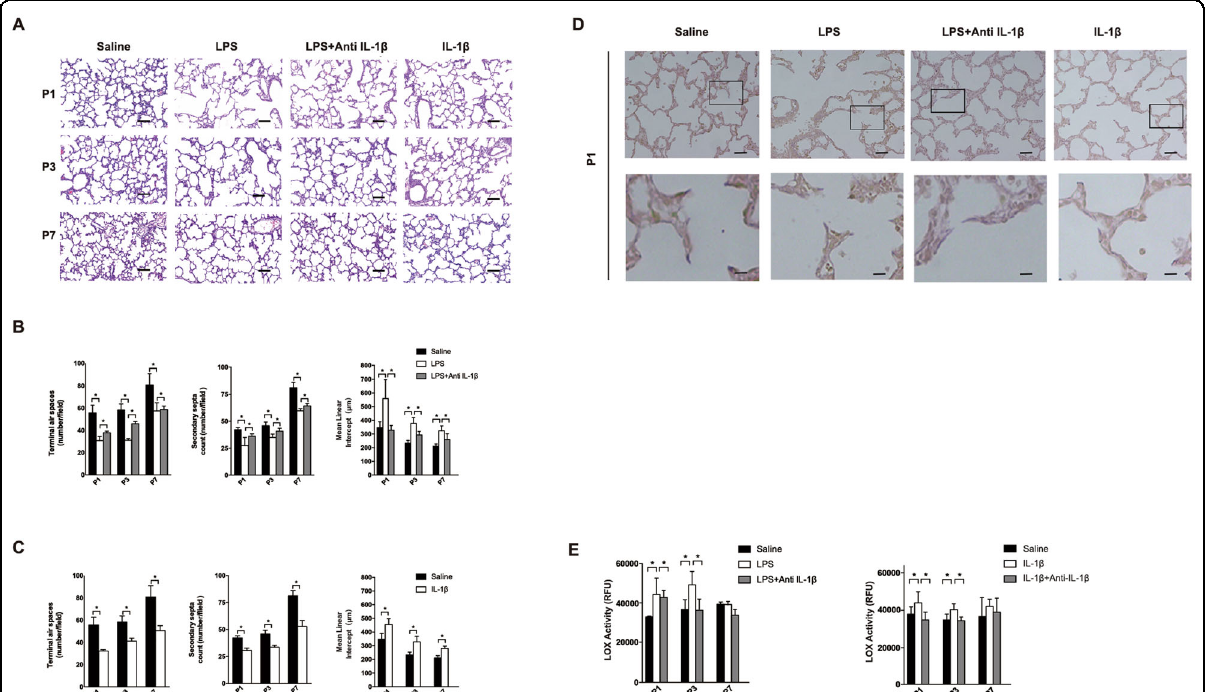
Fig. 1 IL-1 β mediated arrested effects on alveolarization in the alveolar development phase. A Representative lung sections stained with H&E. Scale bar: 50 μ m. B Quanti fi cation of the terminal airspace, secondary septa, and MLI of lung tissues from P1, P3, and P7 rats treated with LPS and anti- IL-1 β antibody. Data are expressed as mean ± SD ( n = 6), * p < 0.05. C Quanti fi cation of the terminal airspace, secondary septa, and mean linear intercept of lung tissues from P1, P3, and P7 rats treated with IL-1 β . Data are expressed as mean ± SD ( n = 6), * p < 0.05. D Representative lung sections stained with gomori (Ampli fi ed). Top: Scale bar: 50 μ m. Bottom: Scale bar: 25 μ m. Treatment with either LPS or IL-1 β resulted in abnormal elastin deposition in the lung septal, whereas adding anti-IL-1 β antibody normalized elastin. E Quanti fi cation of LOX enzymatic activity in whole lung lysate of P1, P3, P7 rats treated with LPS and anti-IL-1 β antibody. Data are expressed as mean ± SD ( n = 7), * p < 0.05. Qua n ti fi cation of LOX enzymatic activity in whole lung lysate of P1, P3, and P7 rats treated with IL-1 β and anti-IL-1 β antibody. Data are expressed as mean ± SD ( n = 7), * p <